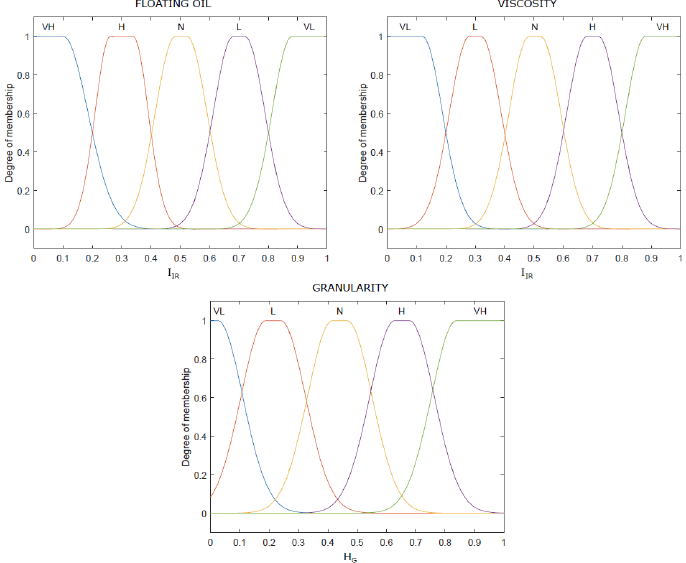
Figure 8. Input fuzzy membership functions.